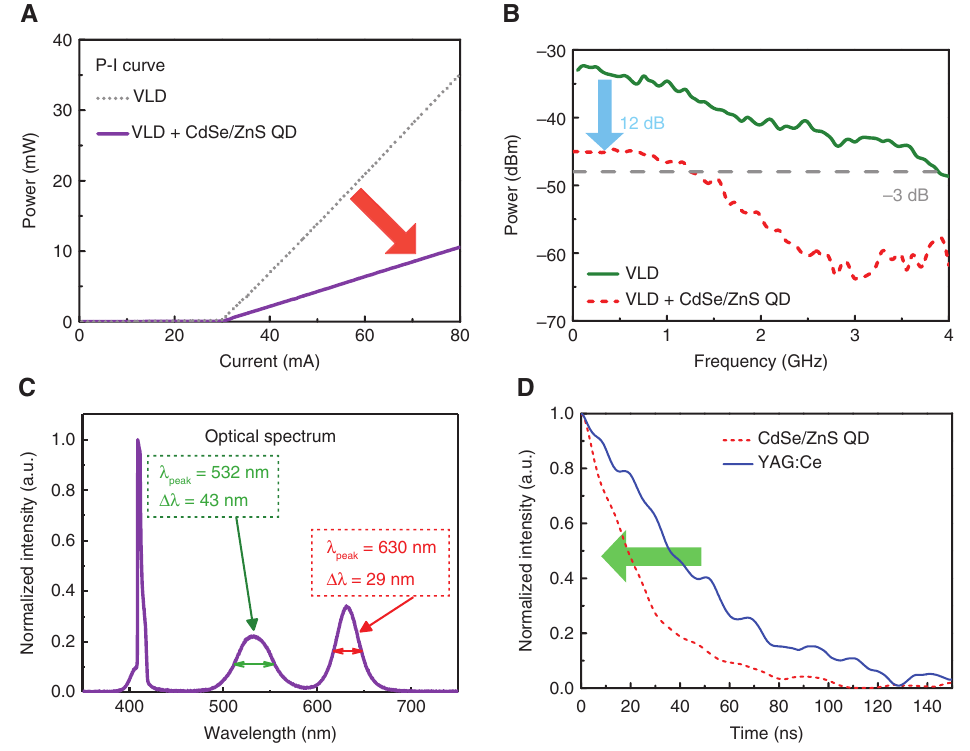
Figure 7: The modulation characteristic of the VLD before and after adhering CdSe/ZnS core-shell-QD doped PDMS film. (A) Power-to-current curve before and after adhering CdSe/ZnS core-shell-QD doped PDMS film; (B) frequency response and (C) optical spectrum of VLD + CdSe/ZnS core-shell-QD based white-lighting source; (D) TRPL response of CdSe/ZnS core-shell ZnS core-shell-QD based white-lighting source at the